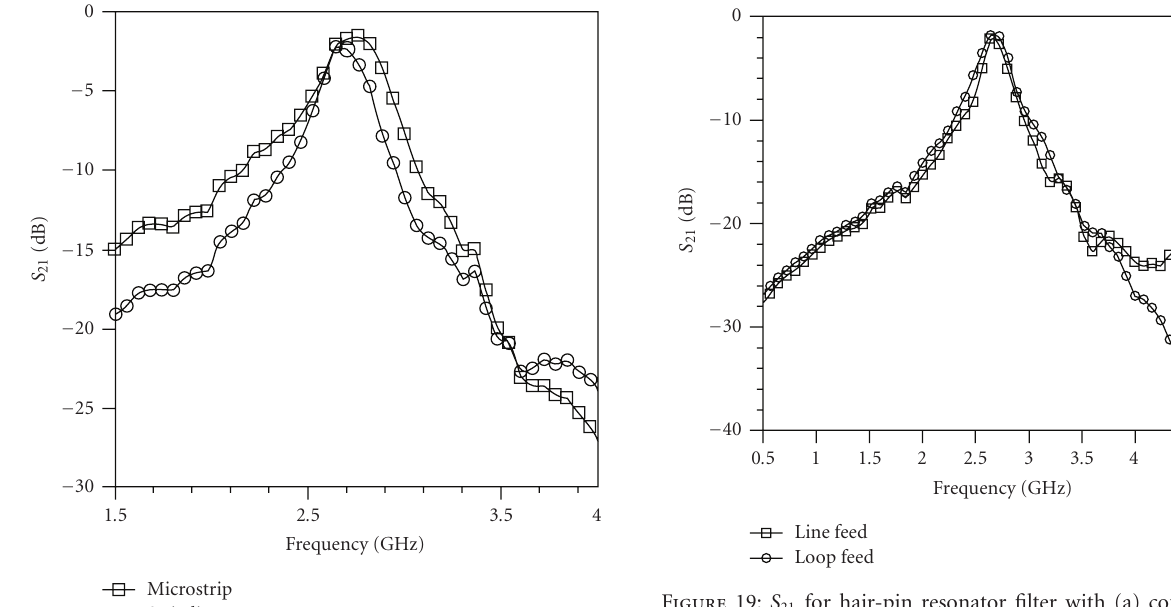
Figure 19: S 21 for hair-pin resonator filter with (a) coupled-line feed and (b) loop